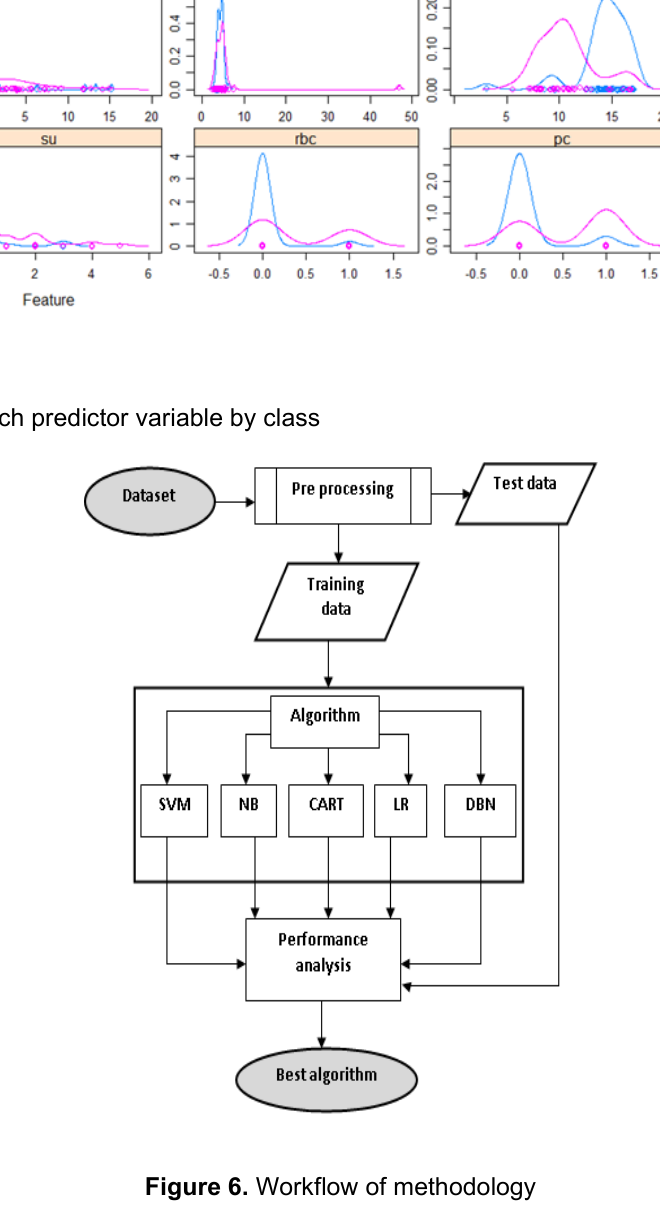
Figure 6. Workflow of